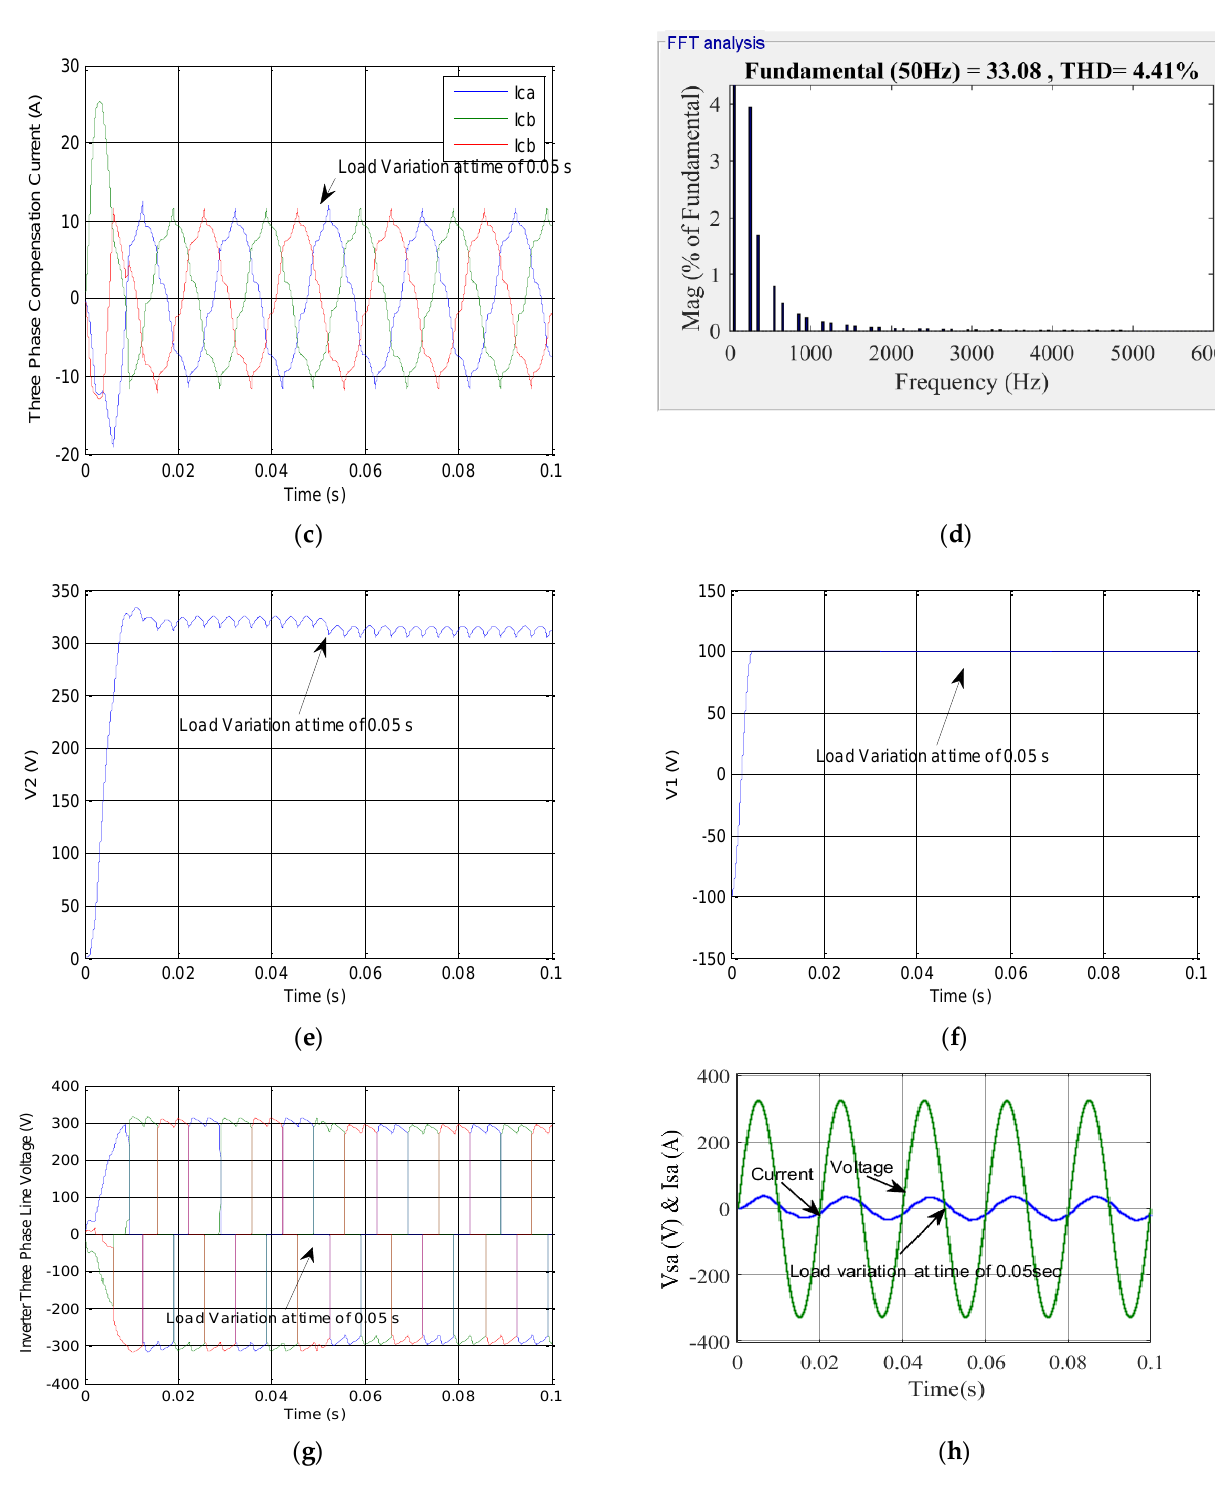
Figure 10. Simulated responses of three phase SSI-based SAPF connected at DRB RC load with HCC and PI controller. ( a ) Supply current, ( b ) load current, ( c ) compensation current, ( d ) THD, ( e ) V 2 DC link voltage, ( f ) V 1 DC link voltage, ( g ) SSI output voltage and ( h ) source voltage (V sa ) and source current (I sa ) of phase A.